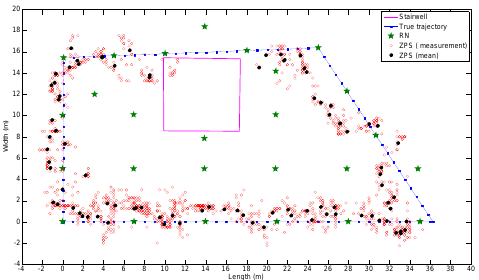
Figure 5. Results for the location estimation using TI ZPS platform as an MT(BN) move along the test